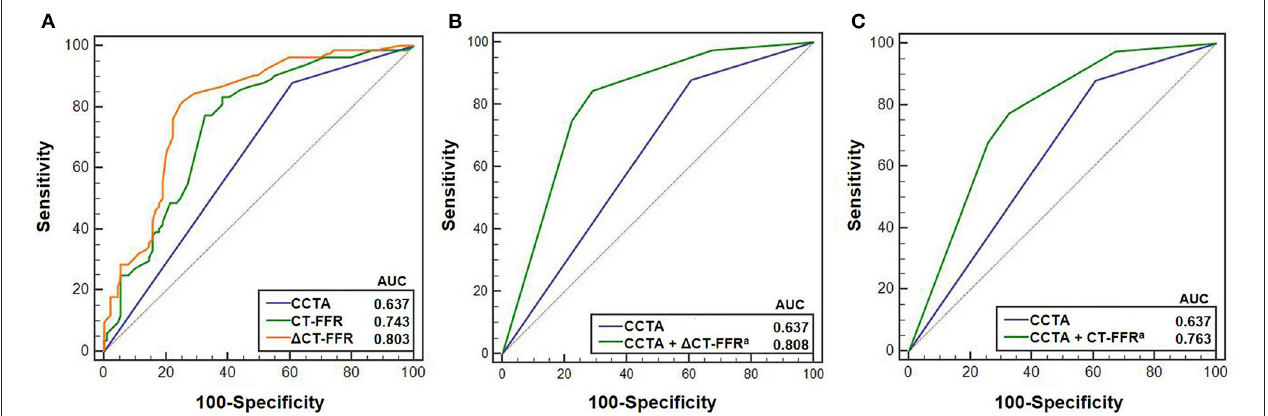
FIGURE 2 | Receiver operating characteristic (ROC) curves of CCTA, 1 CT-FFR, CT-FFR in predicting ischemia ( N = 173 vessels). (A) shows ROC curves for predicting ischemia using CCTA, 1 CT-FFR and CT-FFR. (B,C) show the ROC curves of models using CCTA with and without 1 CT-FFR and CT-FFR, respectively. Cut-off value of 0.15 corresponding to the maximum Youden index was used for the comparison between CCTA with and without 1 CT-FFR. a Indicates there were statistically significant difference between AUC for CCTA and CCTA with 1 CT-FFR and CT-FFR, respectively (B,C) using DeLong test ( 24). CCTA, coronary computed tomography angiography; CT-FFR, computed tomography-derived fractional flow reserve; AUC, area under curve.